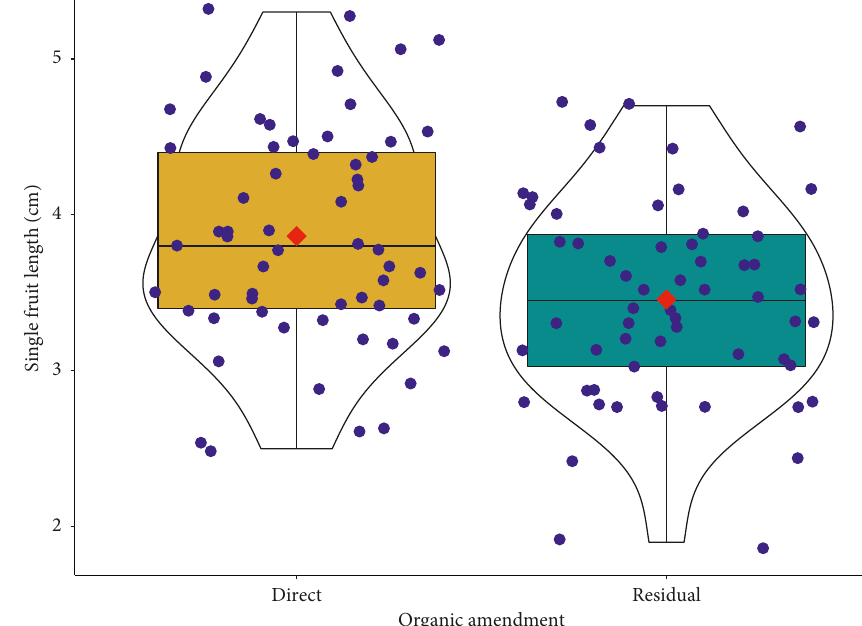
Figure 11: Response of hot pepper single fruit length to organic amendment application